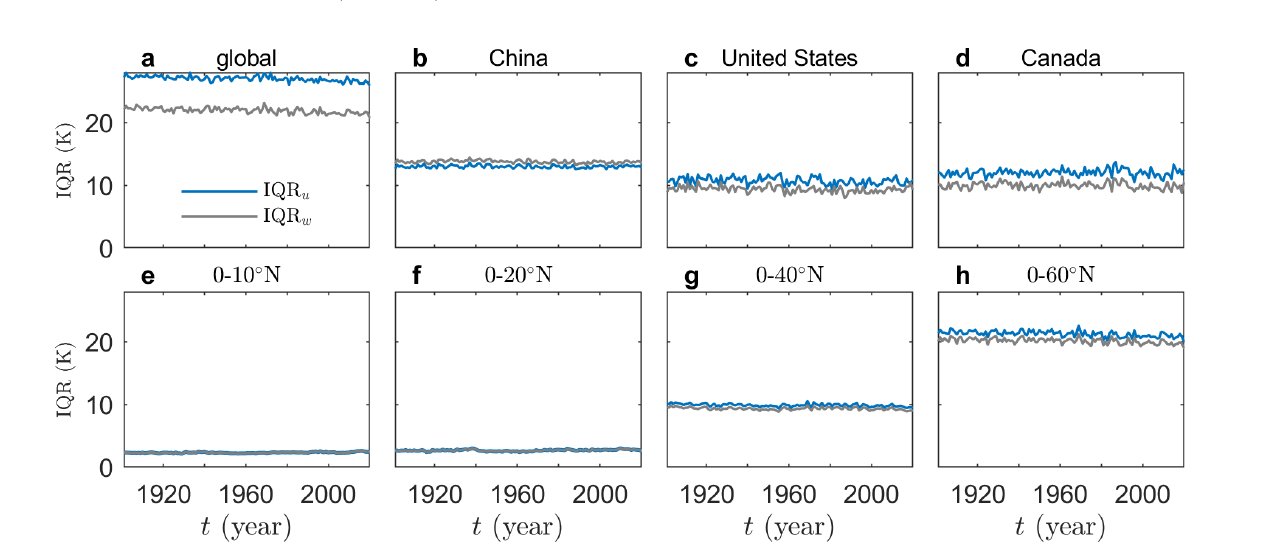
Figure 5. As in Figure 2 but for the first quartile with and without consideration of geodetic weights ( Q 1, w and Q 1, u ).